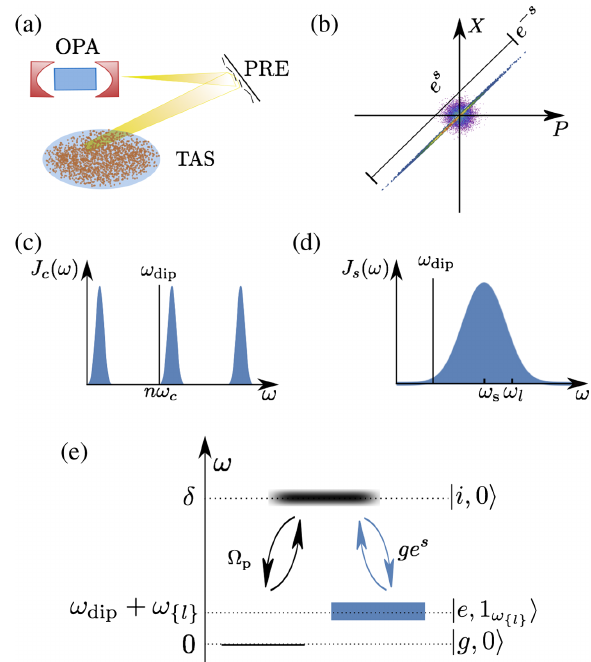
FIG. 1. (a) Experimental setup. The squeezed vacuum is generated via the nonlinear processes in the optical parametric amplifier (OPA) operated below threshold. The squeezed vacuum is then reflected by a programmable reflective element (PRE) such as a SLM or a DMD and focused to a diffraction-limited pattern on the trapped atomic system (TAS). (b) The effect of squeezing in the phase space. Squeezing results in enhanced fluctuations in one quadrature while reducing the fluctuations in ω Þ for a the orthogonal quadrature. (c) The spectral density J c ð dipole placed within a cavity. The boundary conditions imposed by the cavity mirrors result in a highly modified density of states within the cavity. The change in density of states modifies the ω Þ and results in the phenomenology of cQED. (d) The J c ð spectral density for a dipole coupled to the antisqueezed quad- rature of the squeezed vacuum beam with a carrier frequency ω . s The modes within the bandwidth of the squeezed vacuum are labeled by l ∈ f − L; L g . (e) A typical application of squeezed vacuum with squeezing parameter s in a stimulated Raman transition that requires a coherent drive with strength Ω . The p level structure of the quantum degrees of freedom are depicted in the rotating frame of the coherent pump. The labels g and e denote the two metastable qubit states separated by ω , and i dip denotes the short-lived intermediate state whose detuning from the coherent pump is given by δ . All states are shown in a tensor product form (i.e., j (cid:2) (cid:2) (cid:2)i ⊗ j (cid:2) (cid:2) (cid:2)i ) with the state of the squeezed electromagnetic modes. The effective coupling strength between = δ . We note that the the ground and the excited states is ge s Ω p coupling to the dipole operator Eq. (12) is realized when the Raman transition brings the system back to j g i , whereas coupling to the operator in Eq. (13) necessitates a balanced Raman work, when multiple dipoles are placed within the cavity, the dissipative (Purcell) and dispersive (Lamb) effects associated with a single atom translate to dissipative and dispersive interactions between the atoms.